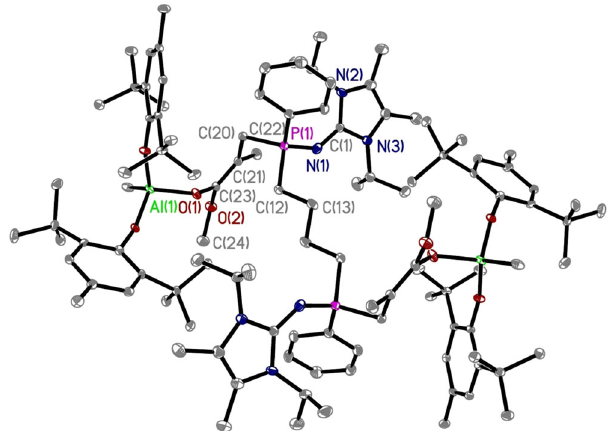
Fig. 4 Structural characterization. X-ray crystal structure of (BHT) 2